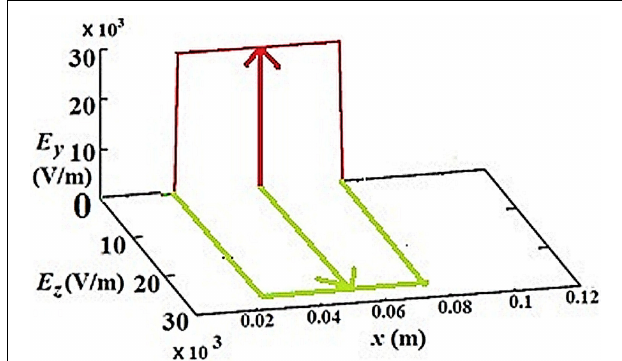
FIGURE 1 | Schematic of the heating field.